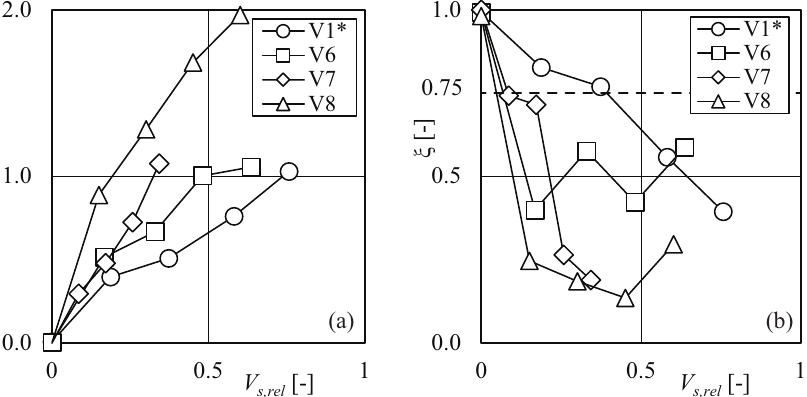
Figure 7. ( a ) Relative backwater rise ∆ h / h o and ( b ) bedload transport reduction factor ξ versus V s , rel for tests V1* ( d L = 1 cm and L L = 15–20 cm), V6 ( d L = 2 cm and L L = 15–20 cm), V7 ( d L = 0.5 cm and L L = 5–10 cm), and V8 ( d L = 0.2 cm and L L = 5